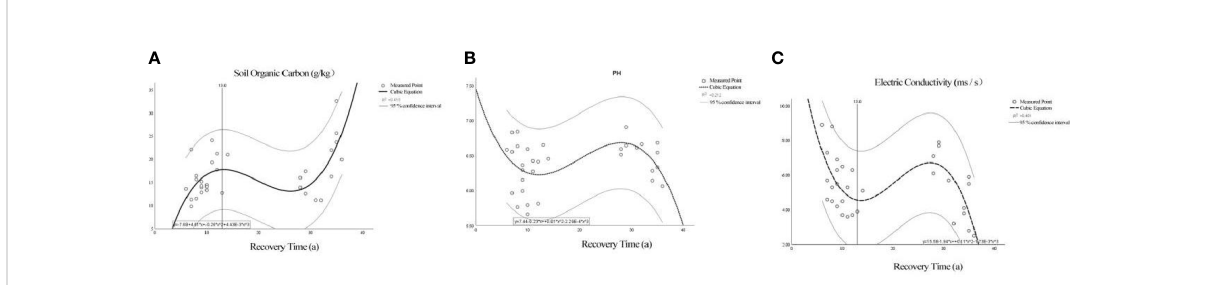
TABLE 5 Recovery process of mollisols after transforming into ecological corridor.